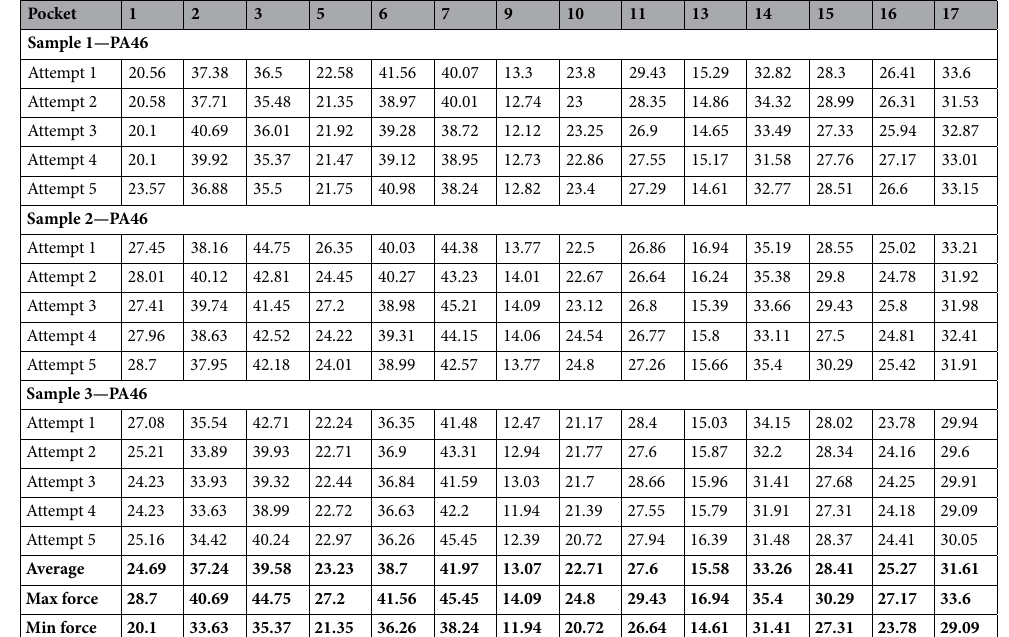
Table 3. Measured forces of PA46 cages. The [Bold] values are used in the subsequent calculations and plots.